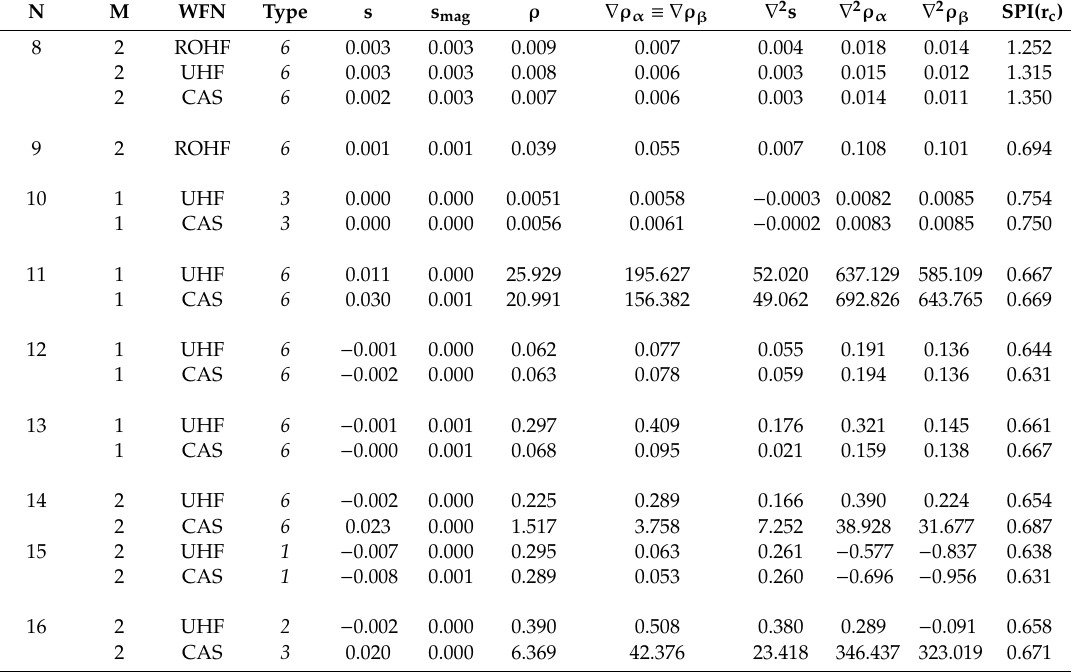
Table 3. Selected properties 1 at the (3, + 1) and (3, + 3) critical points of the 3 B 1 H 2 O molecule for various wavefunction